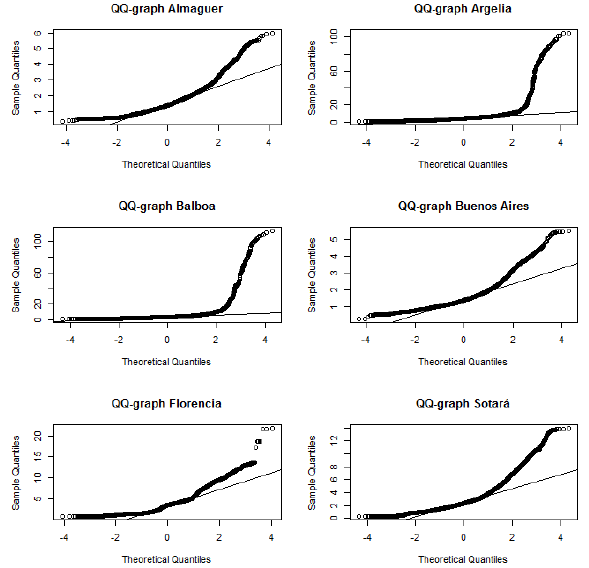
Figure 3: Results of the Q-Q graph as visualization tool of the normality of the GPS horizontal